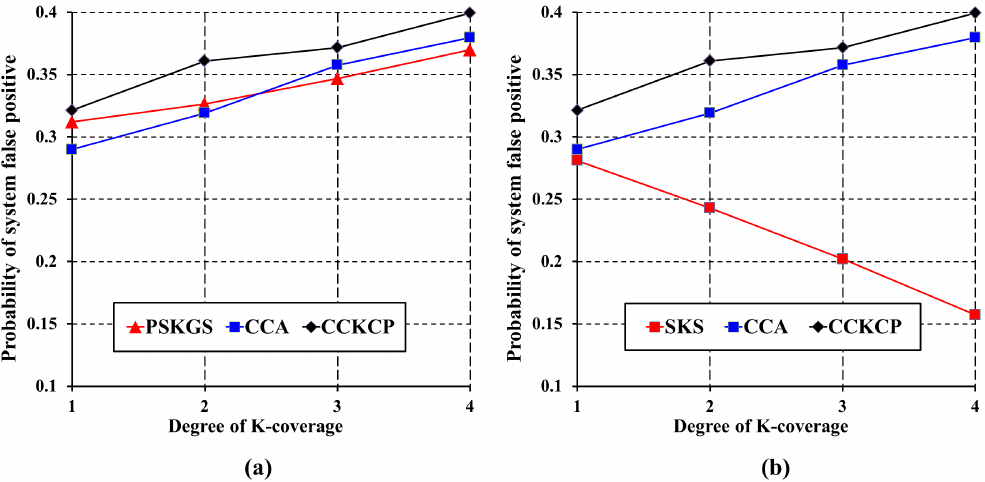
Figure 16. Probability of system false positives of ( a ) PSKGS, CCA [31] and Centralized and Clustered K -Coverage Protocol (CCKCP) [32] and ( b ) SKS, CCA [31] and CCKCP [32], with the detection threshold θ = 3 and the data aggregation ratio δ = 0.3.